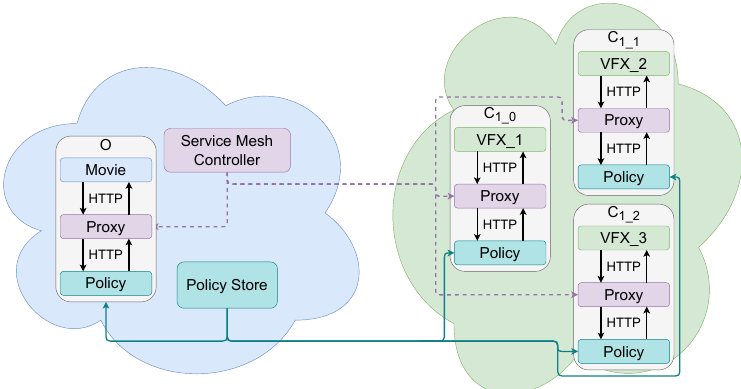
Figure 3. Representative subset of the secure infrastructure control plane (contractors C 2 through C 4 are not represented). Proxies are configured by the service mesh controller, providing them with identities and key pairs, as well as routing information for them to initiate secure communications with other proxies in the mesh. Policy changes are enabled with periodical pull on the policy sidecars (whose input comes from a policy